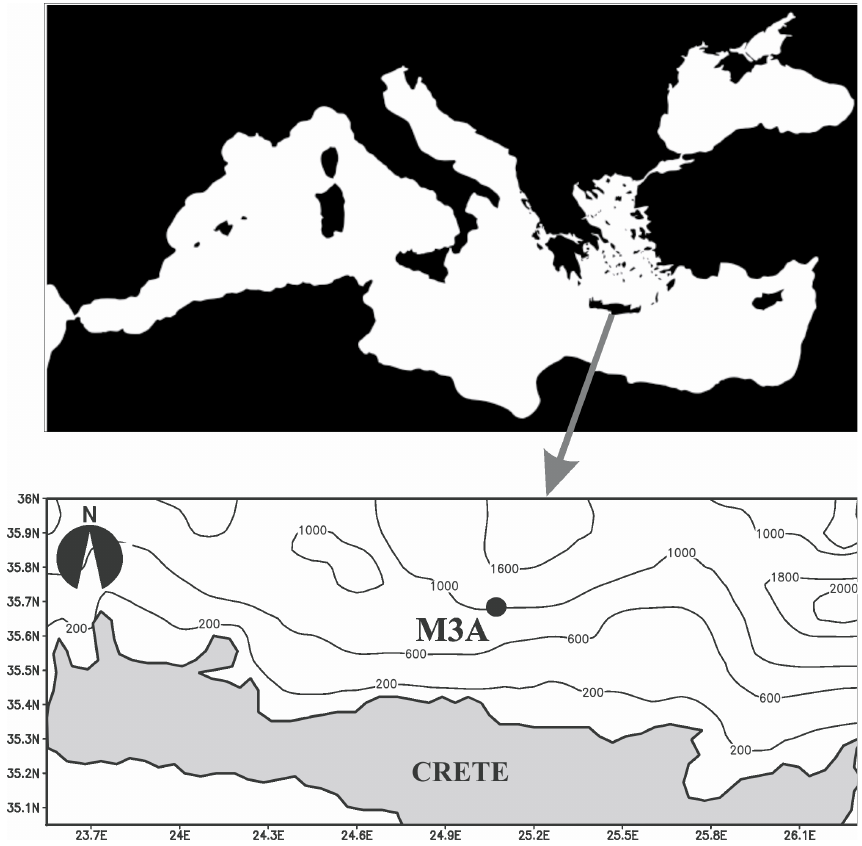
Fig. 3. Map showing the Mediterranean Sea and the site of the M3A